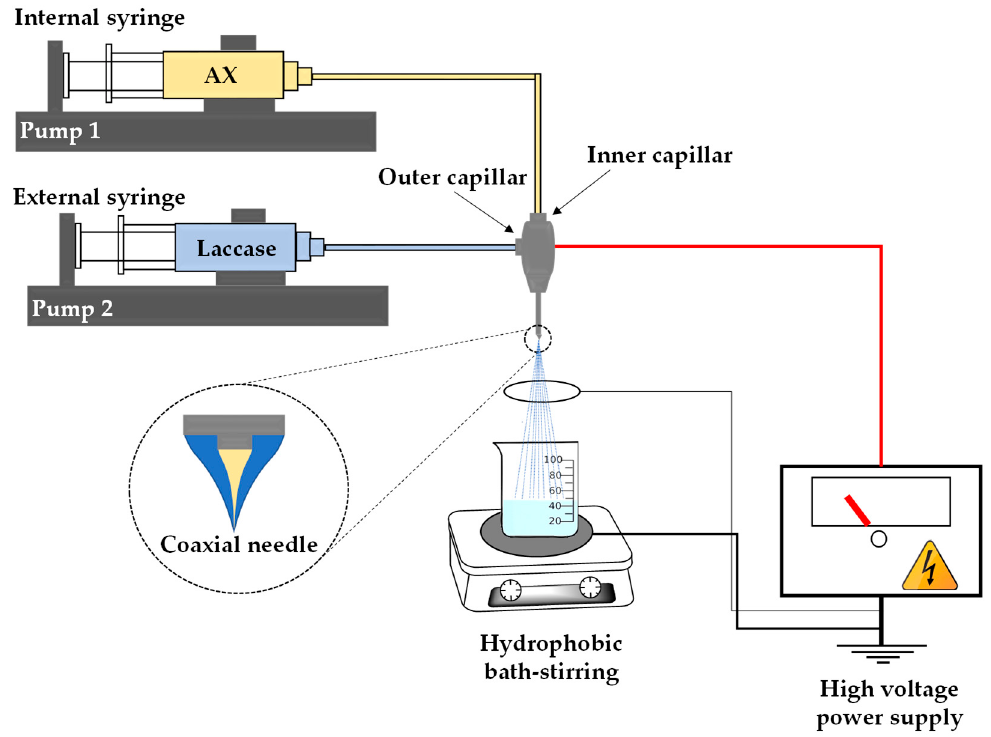
Figure2. Figure 2. Representation of cross-linked nanoparticles (NAX) fabrication by coaxial electrospray method.